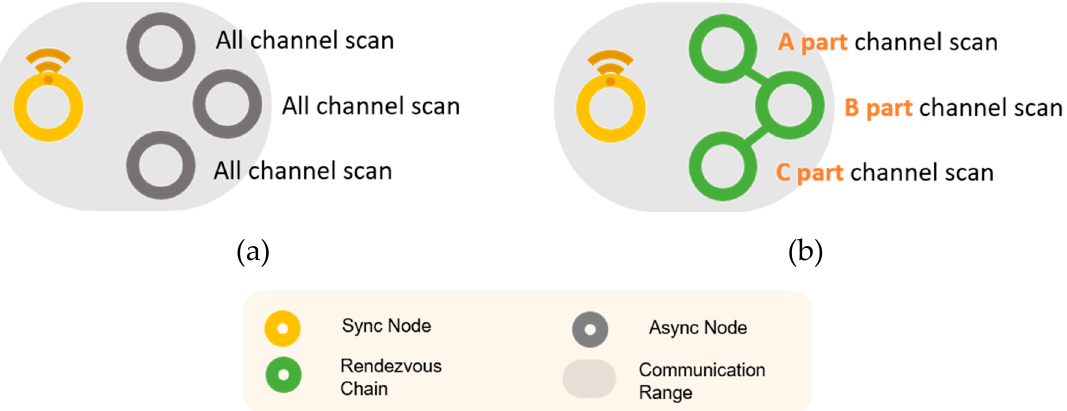
Figure 5. Distributed Radio Listening Through the Rendezvous Chain ( a ) Listen to all channels ( b ) Listen to the radio by dividing the channel.